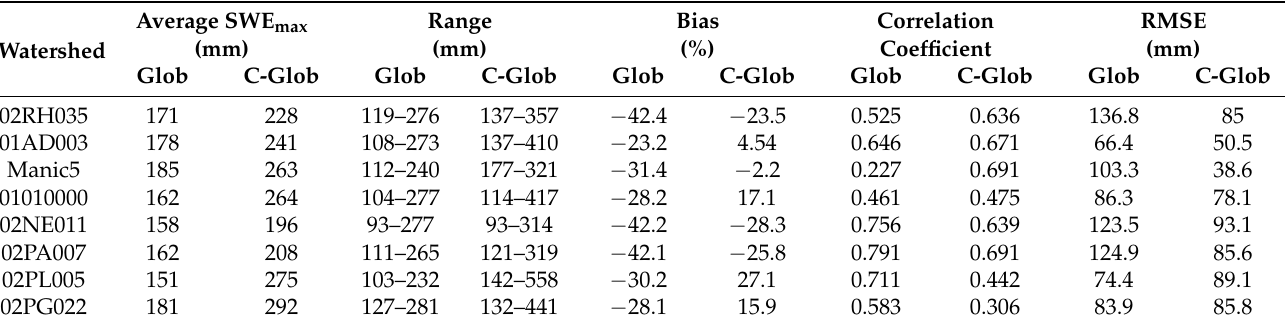
Figure 6. Scatter plots of in situ SWE max data against the original and corrected GlobSnow products for ( a ) 02RH035, ( b ) 01AD003, and ( c ) Manic5 watersheds. Corrected GlobSnow with recommended baseflow separation factor β = 0.925 and with optimal β value are shown. The dashed line represents the 1:1 line. Table 4. Statistical summary of the original (Glob) and corrected (C-Glob) SWE max . A negative bias means that GlobSnow and corrected GlobSnow underestimate SWE relative to the reference (in situ)